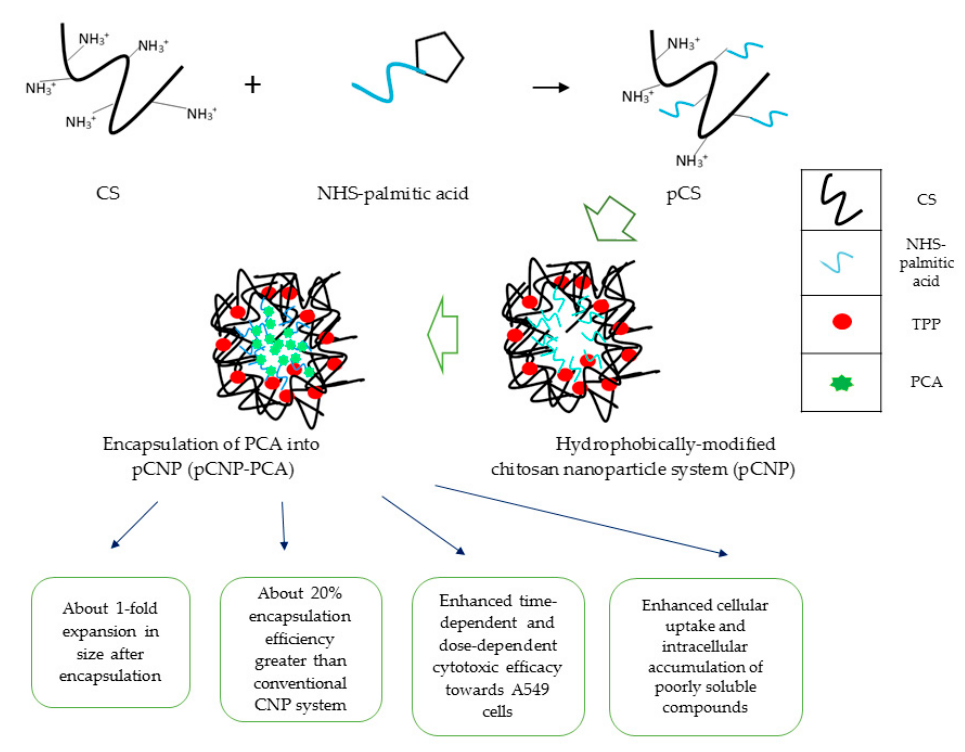
Figure 1. Overview of the study.